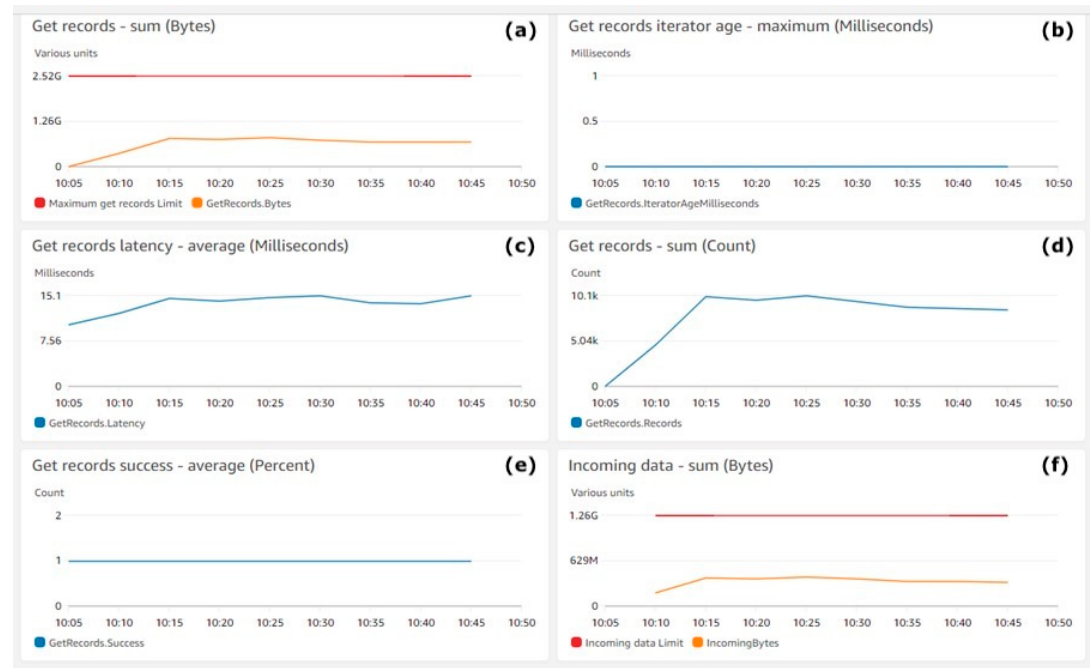
Figure 6. Kinesis Data Stream get records: ( a ) Get records—sum (bytes), ( b ) Get records iterator age—maximum (millisec- onds), ( c ) Get records latency—average (milliseconds), ( d ) Get records—sum (count), ( e ) get records success—average (percent), ( f ) Incoming data—sum (bytes).